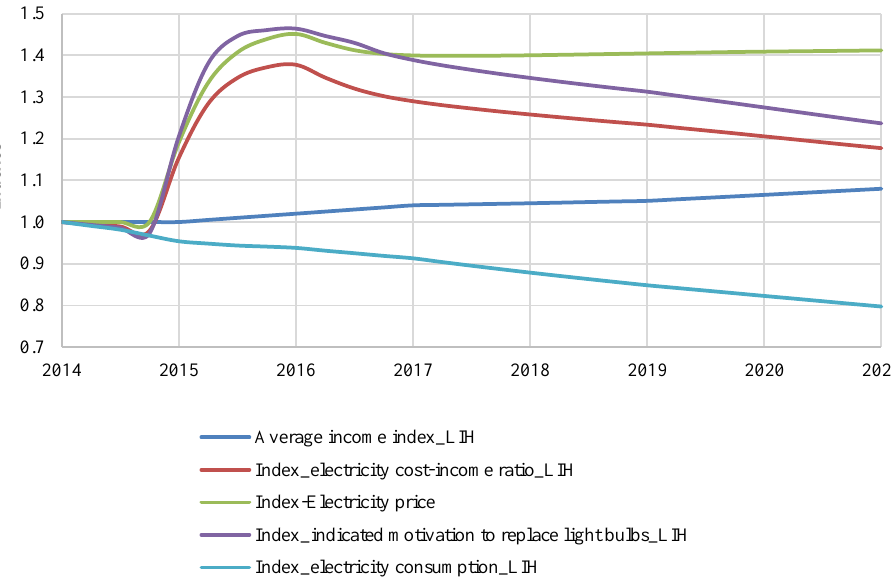
Fig. 10. Indexes of electricity price and low income household (LIH) electricity consumption, average income, electricity cost-income ratio, indicated motivation to replace light bulbs. The index of electricity consumption in the high income households increases (Fig. 11) because of increasing share of the high income households due to economic growth. If the share of the high income households is set constant in the model then electricity consumption decreases in both